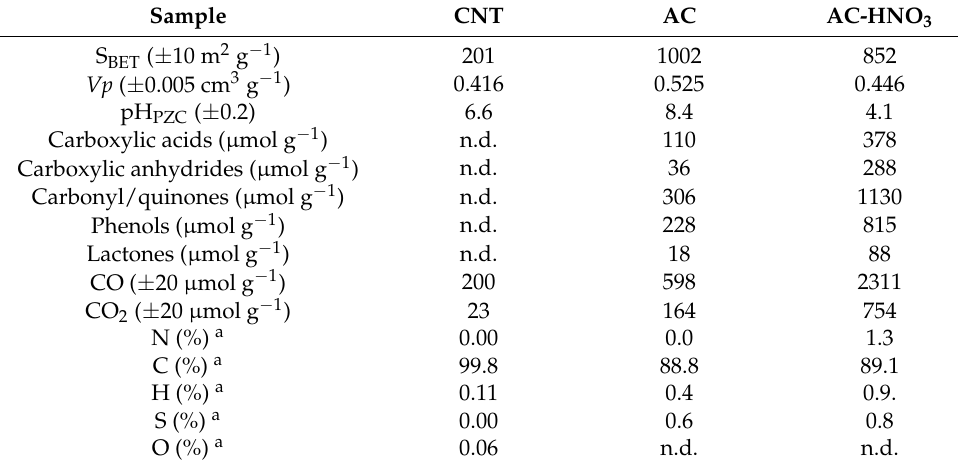
Table 3. Results of the characterization of tested CM